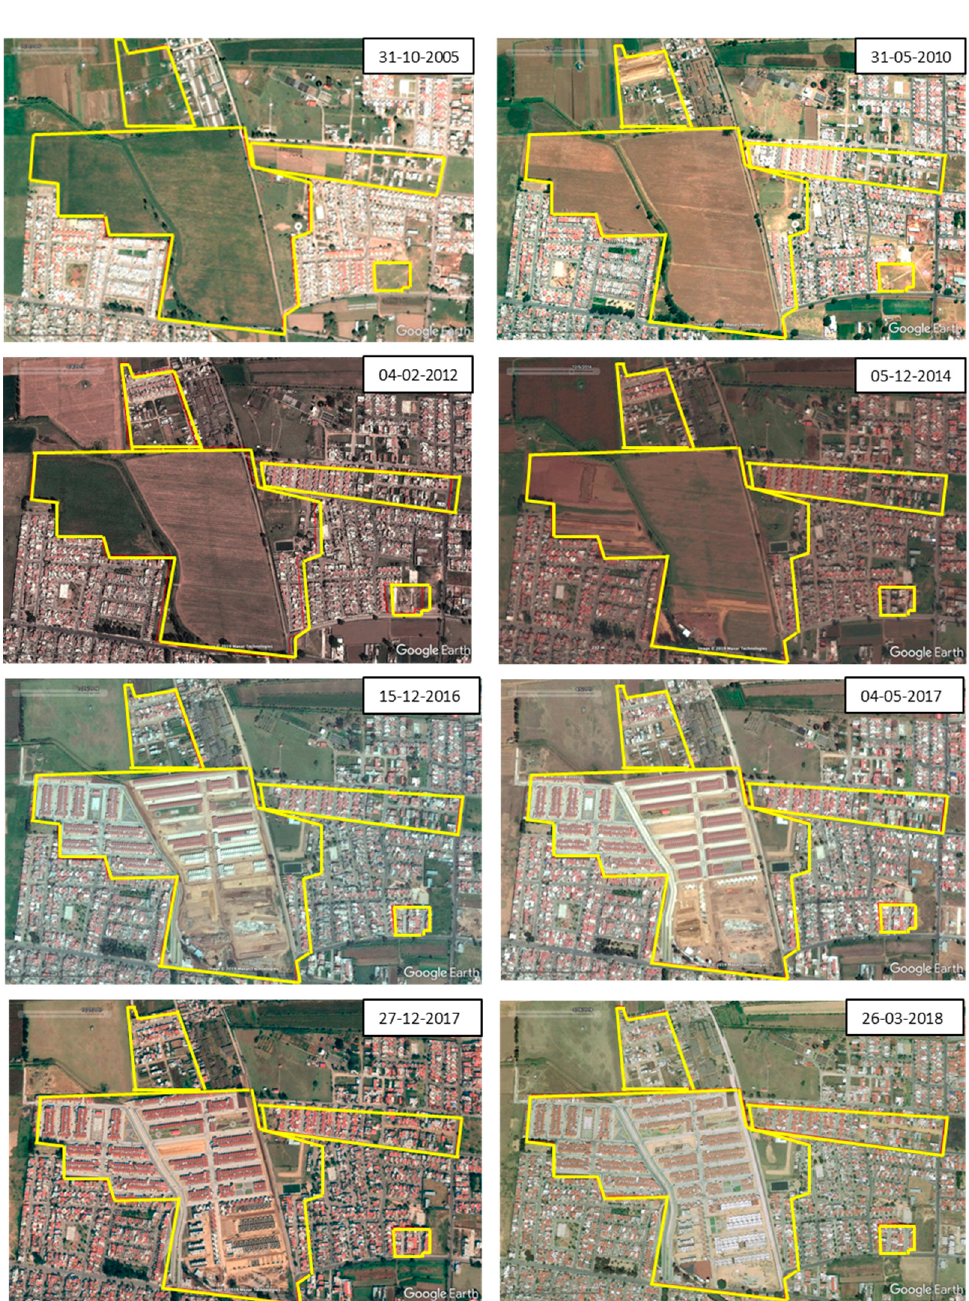
Figure 12. The urban expansion localized on the North-Western side of Ciùdad Guzman. The yellow lines indicate areas experiencing urban expansion in the 2005–2018 time period and, in particular after 2014. Time series of images with the Google Earth Time Slider tool provided by Google Earth Pro (v. 7.1.5.1557). The considered area refers to the black ellipses of Figure 4 and to the yellow ones in Figure 13.